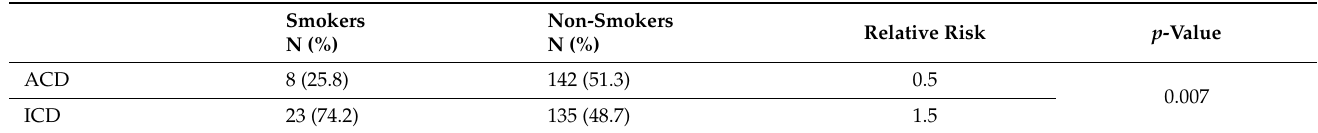
Table 2. Effect of smoking on the prevalence of ACD and ICD.